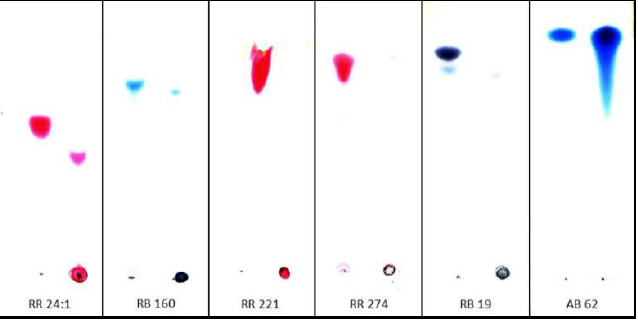
Figure 11. TLC chromatography coloured compounds obtained in reactions between reactive dyes and acid dye with [IME] + Cl − (left side—analysed dye, right side—the reaction product of dye with [IME] + Cl − ).